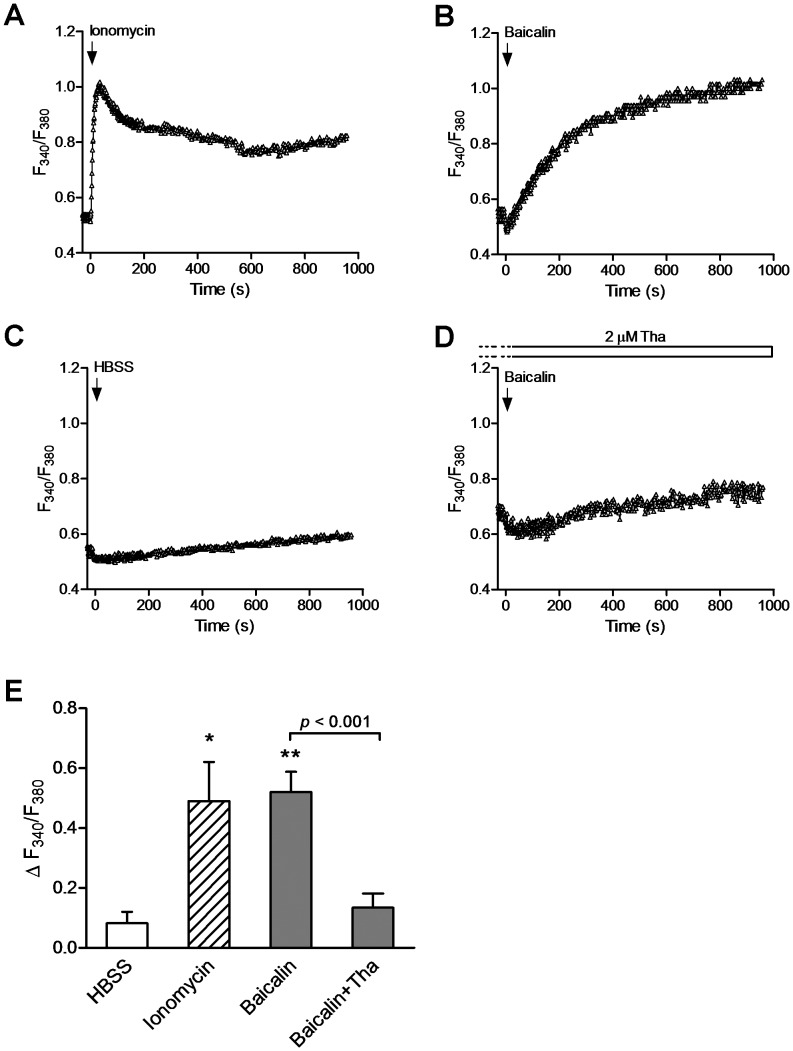
Baicalin increases the intracellular Ca2+ levels in HeLa cells.Traces show the increases in intracellular Ca2+ levels in response to application of ionomycin (1 µM) (A), baicalin (5 µM) in HBSS solution (B) and after depletion of intracellular Ca2+ stores by thapsigargin (Tha, D), as well as application of HBSS solution (C) in HeLa cells loaded with Ca2+ indicator fura 2-AM. Intracellular Ca2+ levels were estimated as the ratio of the signals (F340/F380). (E) Histogram summarizes the changes of intracellular Ca2+ levels (ΔF340/F380) measured after application of HBSS (open bars, n = 3), ionomycin (peak values, hatched bars, n = 3), baicalin in HBSS (solid bars, n = 7) or in the presence of Tha (solid bars, n = 3). * p<0.05 and ** p<0.01 compared to HBSS control; p<0.001 compared between two groups as indicated.